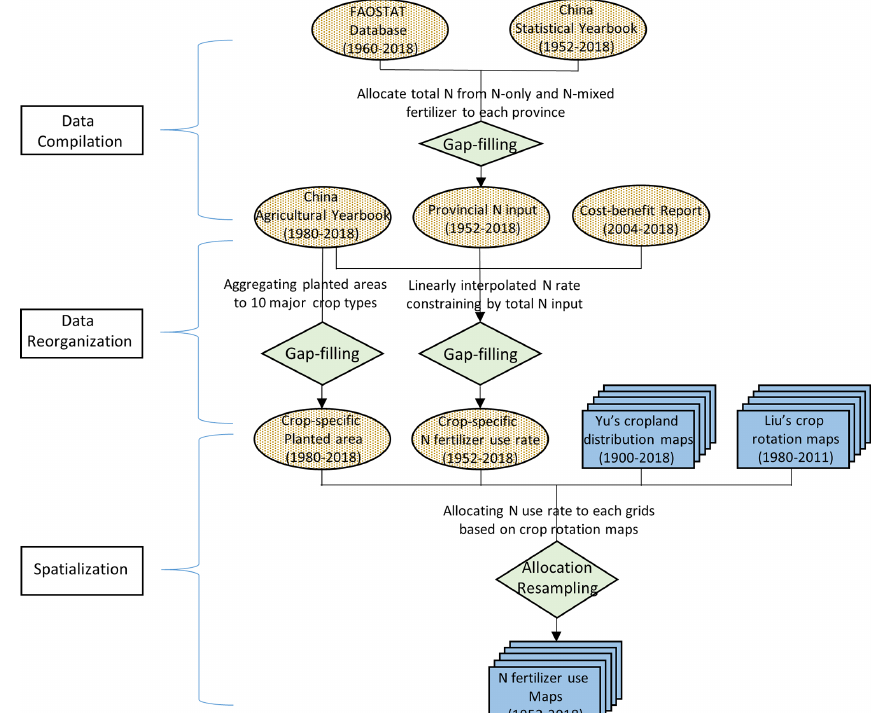
Figure 1. Methodology flowchart of the nitrogen (N) fertilizer map reconstruction.